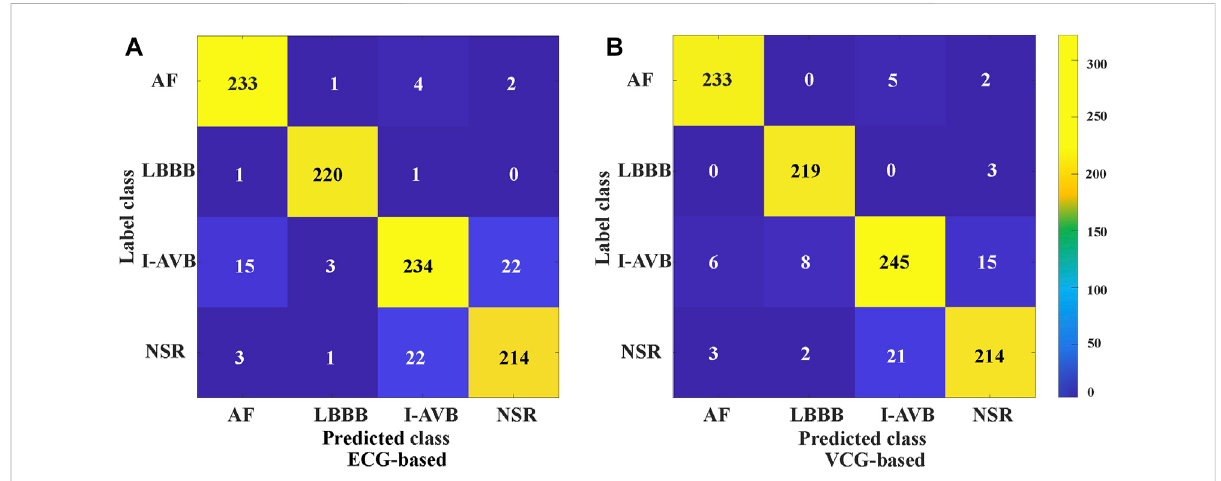
FIGURE 8 The confusion matrix of CA classi fi cation based on 3DRP ECG-based, and VCG-based.